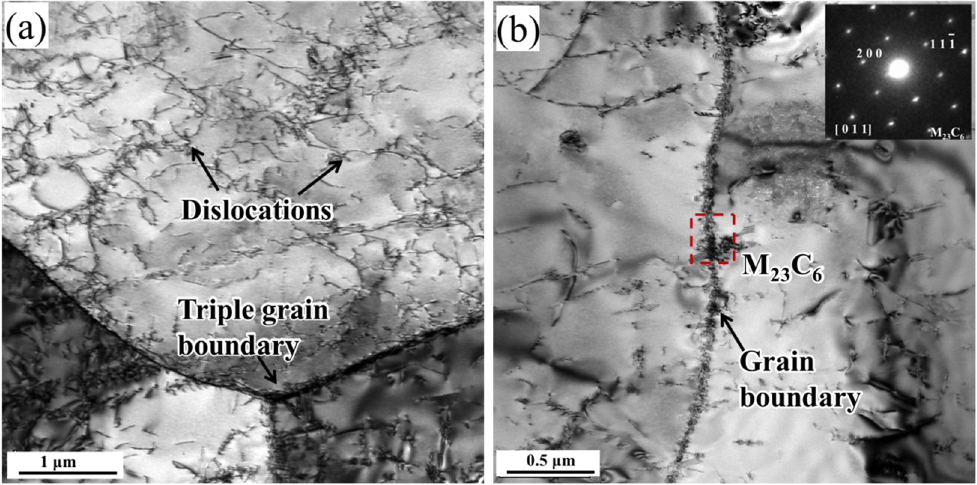
Figure 7. TEM observation of the as-welded samples: ( a ) triple grain boundary and ( b ) austenite grain boundary.